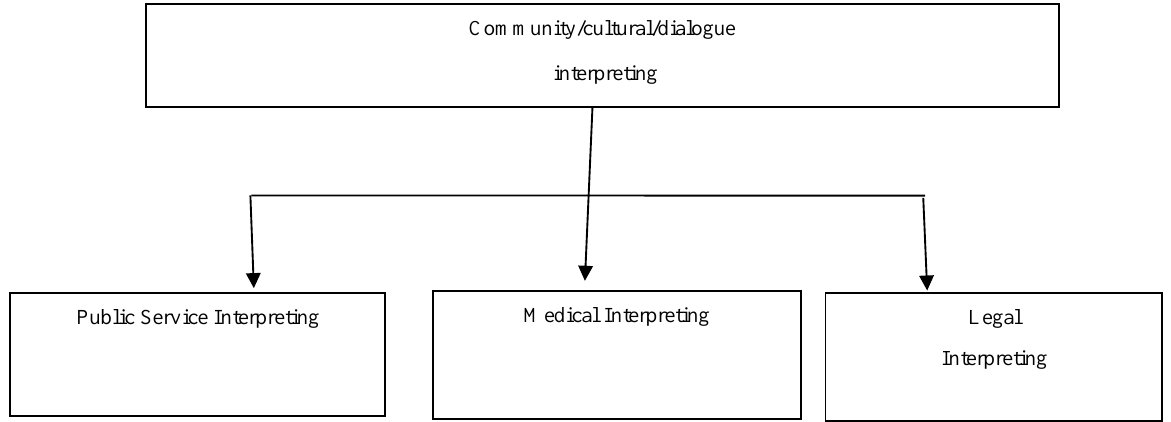
Figure 1: Varieties of Community İnterpreting; Source: Carr et al. (1997: